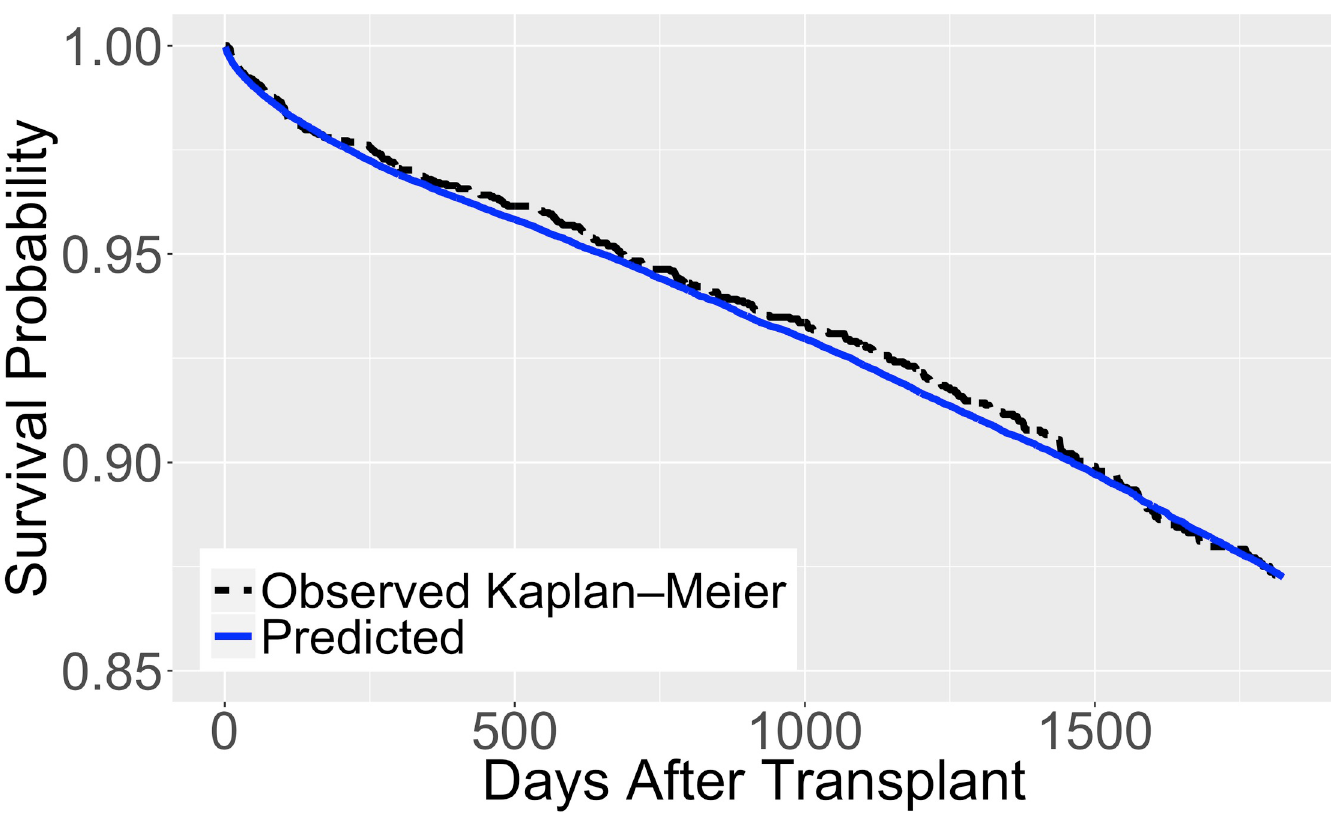
Fig 6. Predicted survival of the proposed model for a ‘typical’ kidney transplant recipient. Trained on 100,000 observations and validated on 25,000 out-of-sample observations. In the out-of-sample data, an observation is considered ‘typical’ if the values are within one standard deviation of the mean for recipient age, donor age, and cold ischemia time, and the most common values from the data for recipient diabetes, recipient dialysis status, recipient medical condition, and donor hypertension